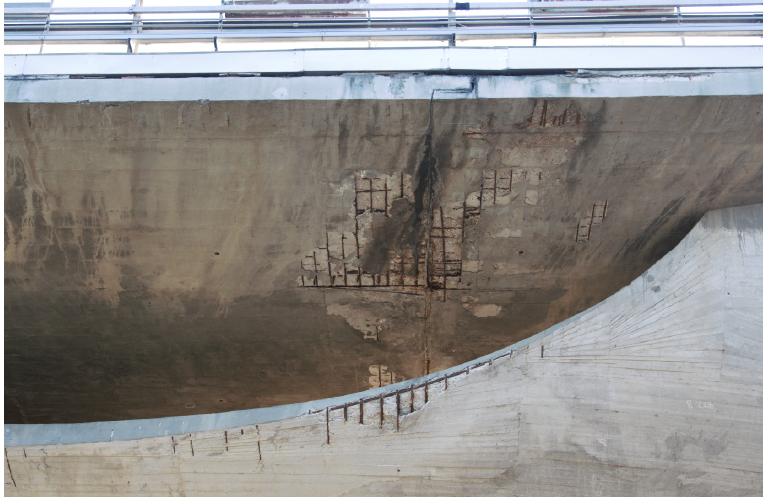
Figure 7. Deterioration of Gerber saddles and underlying vault.